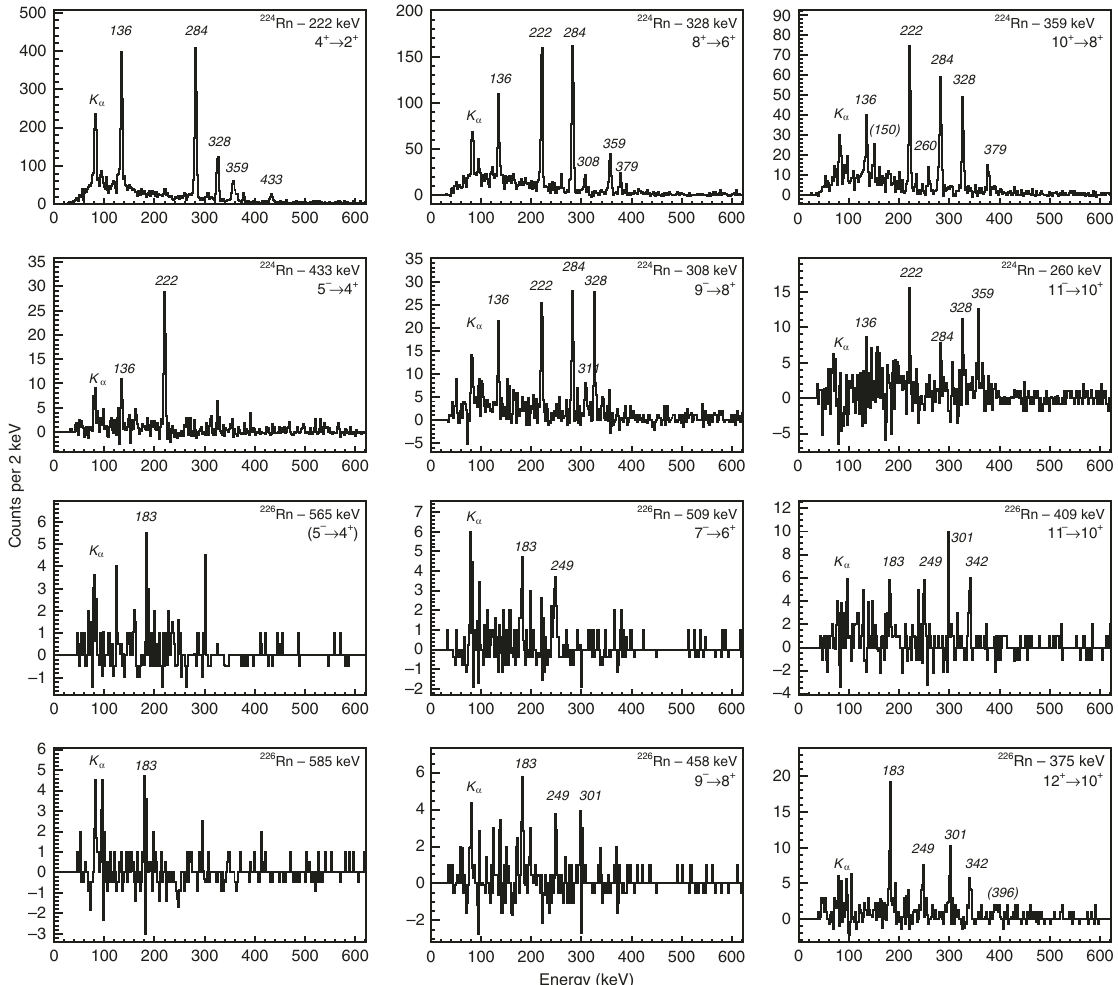
Fig. 2 Coincidence γ -ray spectra. The representative background-subtracted γ -ray spectra are in time-coincidence with different gating transitions. Here the observed peaks are labelled by the energy (in keV) of the transition. The gating transition is additionally labelled by the proposed spin and parity of the initial and fi nal